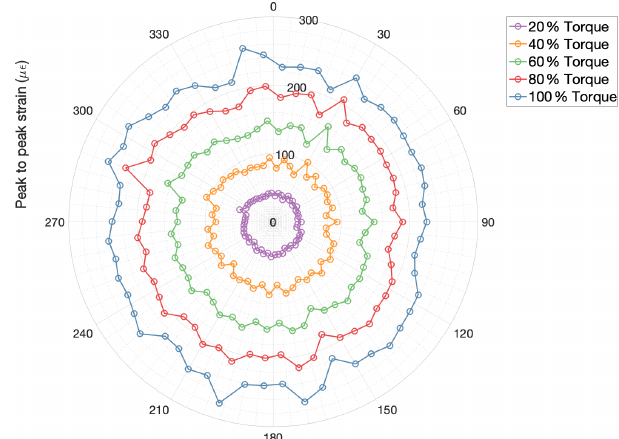
Figure 7. Average peak-to-peak strain values of all 54 sensors for five different torque levels (20%, 40%, 60%, 80%, and 100% torque).